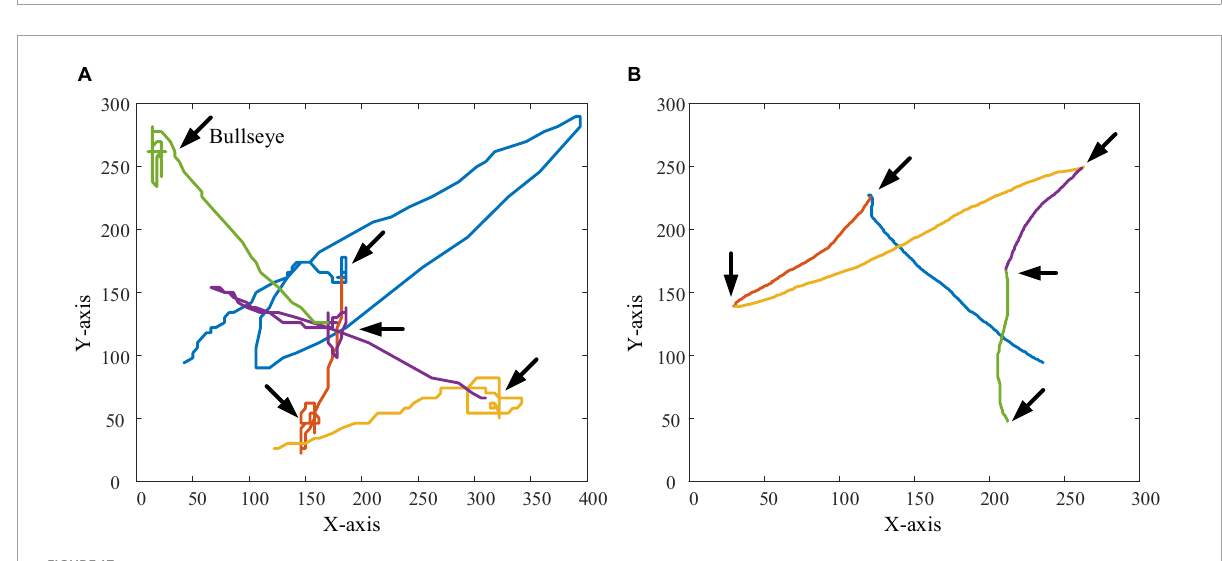
FIGURE17 The figure shows the trajectories of the sight in the target positioning task. The position indicated by the arrow in the figure is the bullseye position. (A) The trajectories of the sight in the control session. (B) The trajectories of the sights in the testing